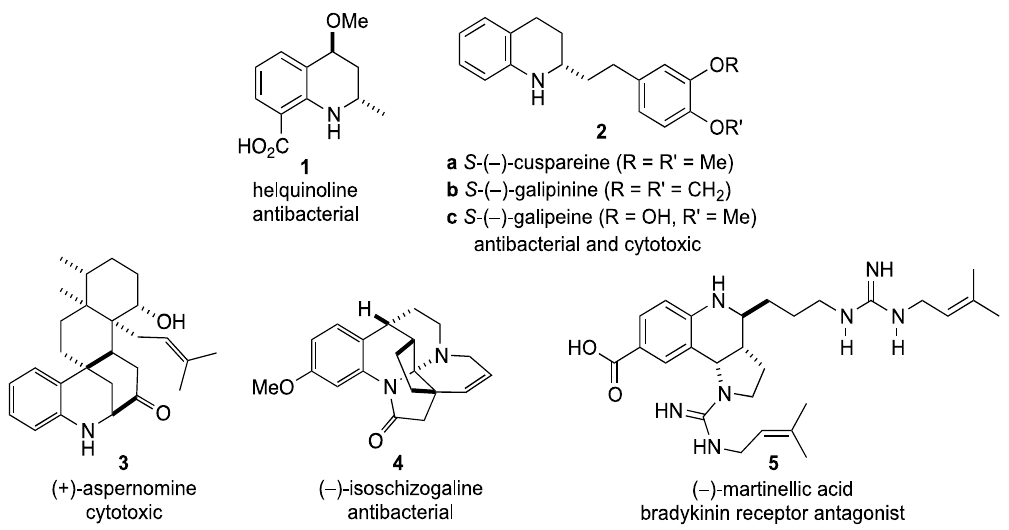
Figure 1. Natural products incorporating